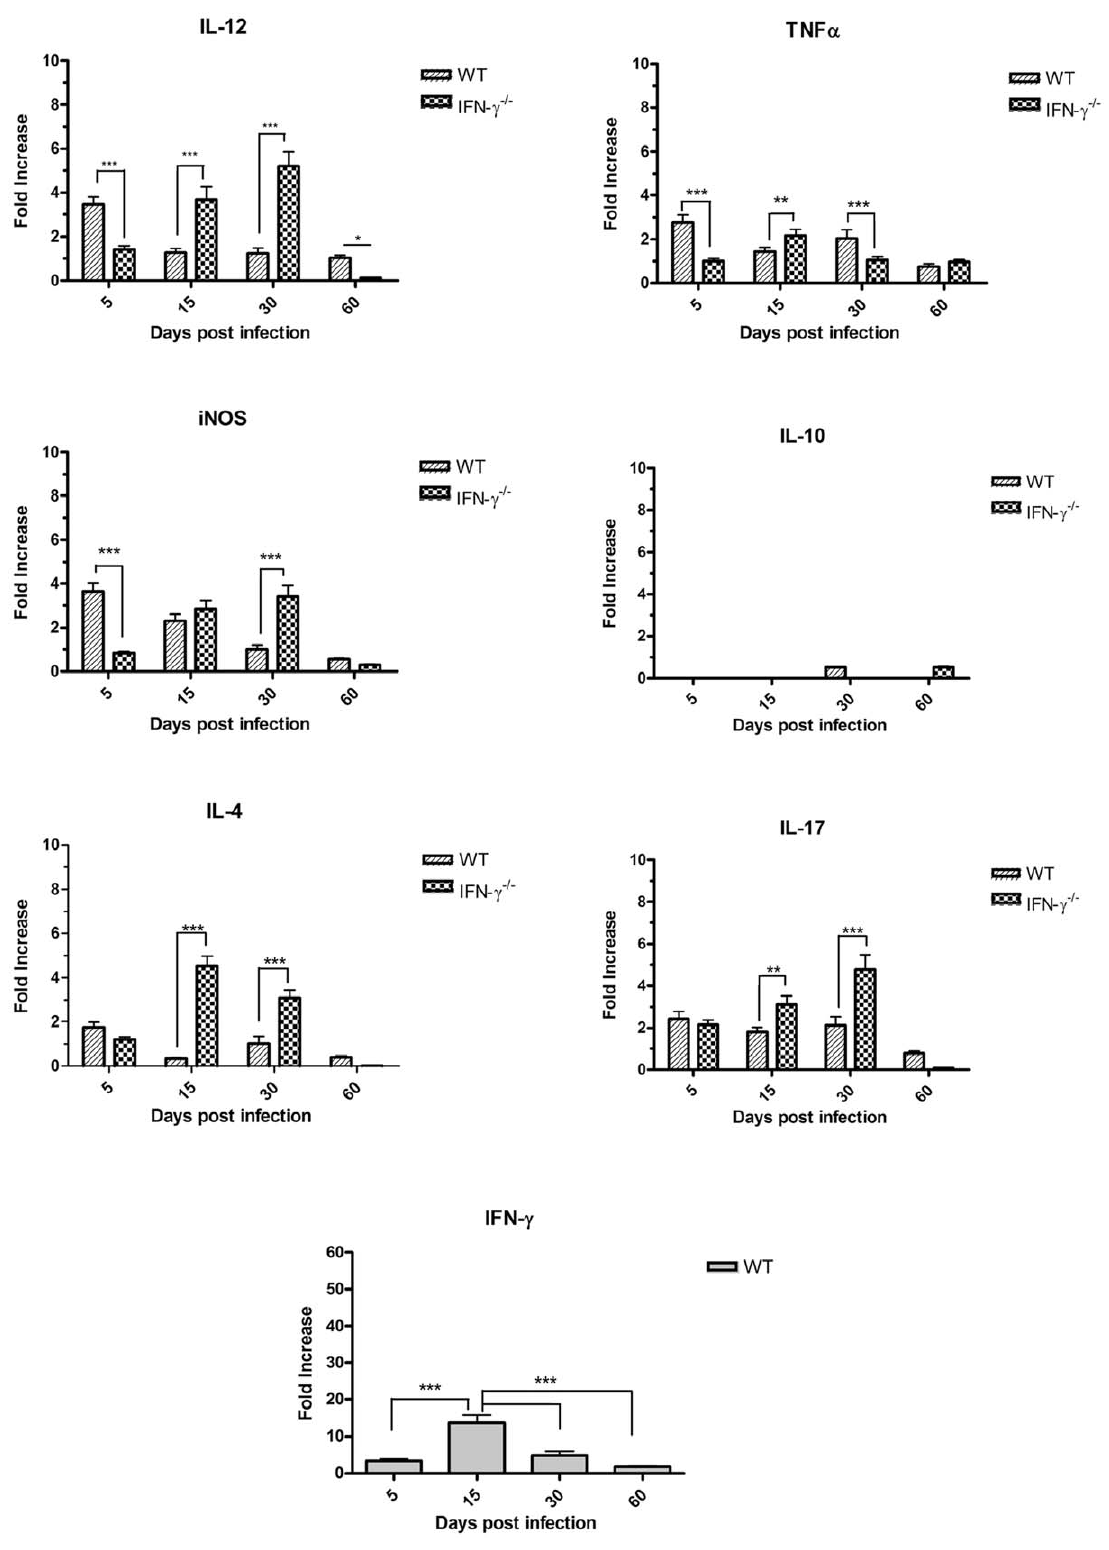
Figure 5. Expression of cytokine genes in lung cells of mice infected with P104 strain. C57BL/6 and GKO mice were infected as indicated in the legend to Fig.2. mRNA was extracted from lungs of these mice on days 5, 15, 30 and 60 post-infection. Levels of mRNA were quantified by real-time PCR using specific primers for inflammatory cytokine genes and normalized to the level of b -actin expression. Cytokine gene expression determination was performed with four animals per time-point. The data were obtained in two independent experiments. Results are expressed as fold increase 6 SEM compared to non-infected animals. Asterisks represent statistical significance (**p , 0.01, ***p , 0.001) when compared WT and GKO mice. doi:10.1371/journal.pone.0021673.g005 PLoS ONE |